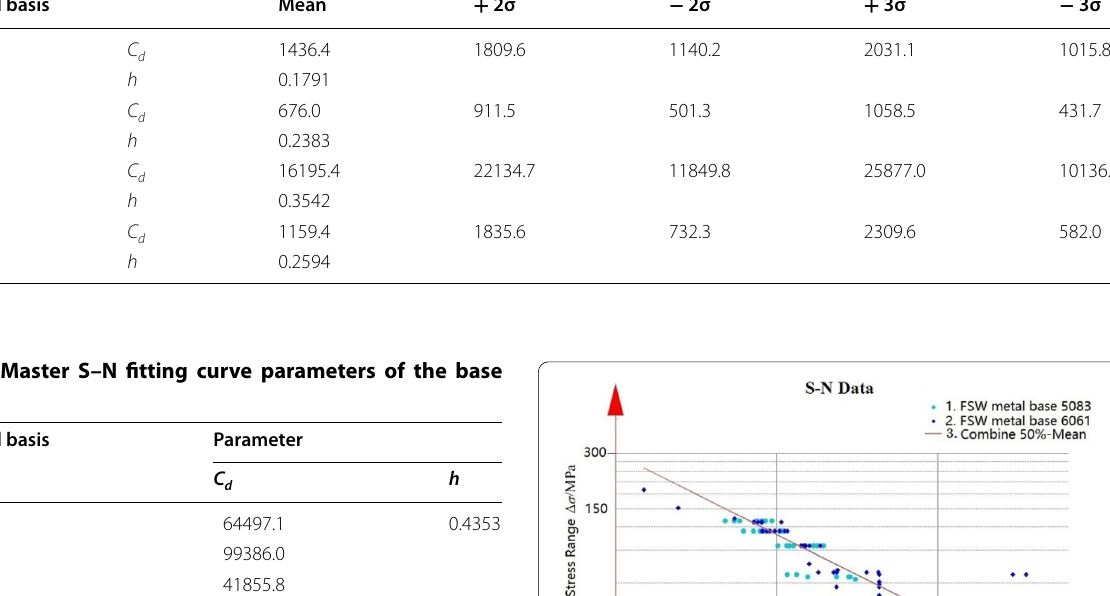
Table 4 FSW nominal stress fitting curve parameters Statistical basis